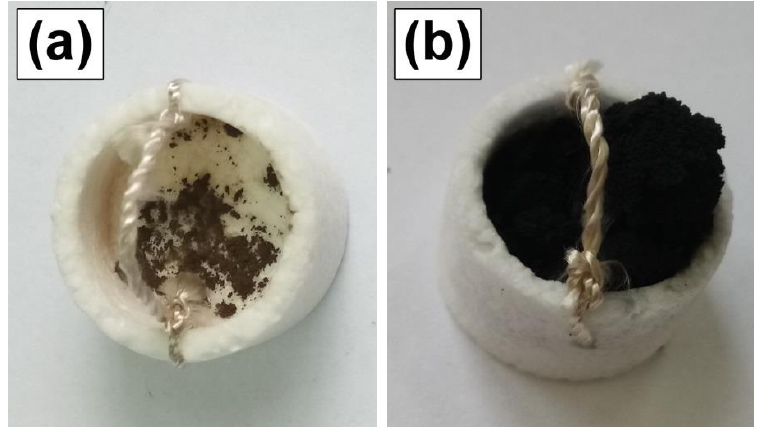
Figure 7. Photographs of the quartz basket: ( a ) with the initial catalyst; ( b ) with the carbon product, after 2 h experiment at 625 °C.